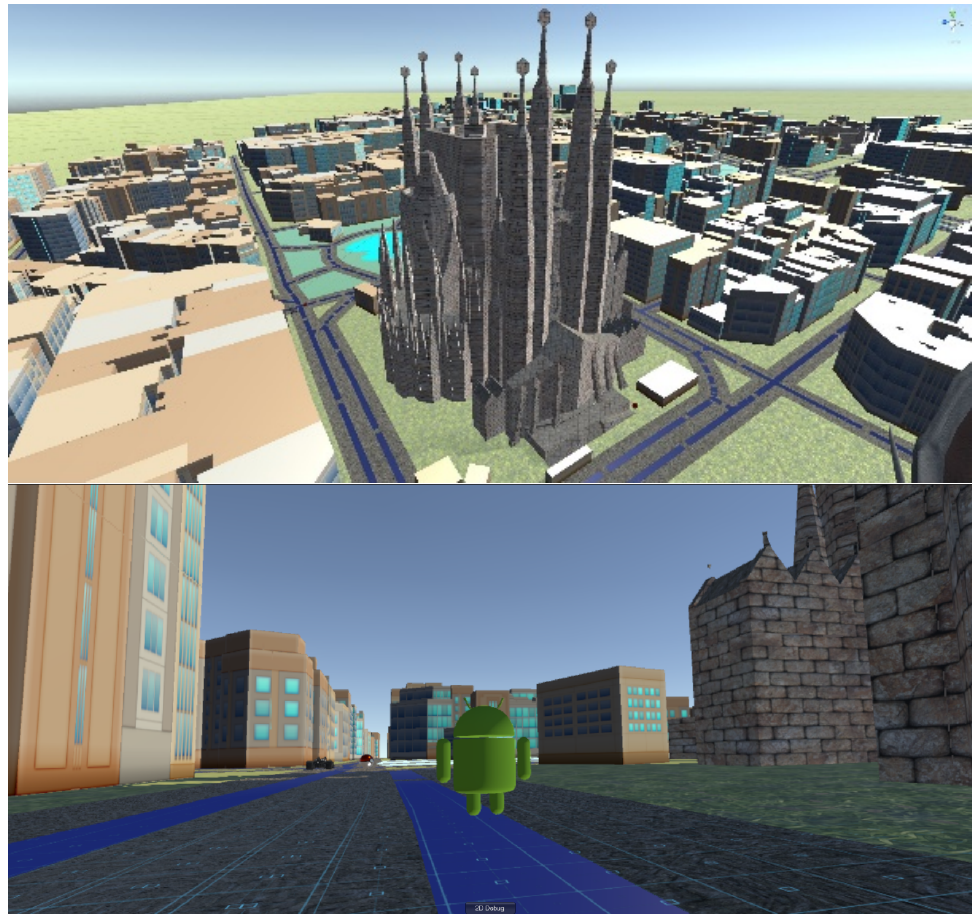
Figure 3. The experiment’s virtual environment and attractions. Up : The La Sagrada Familia in the virtual guided tour. Down : The user’s view during the guided